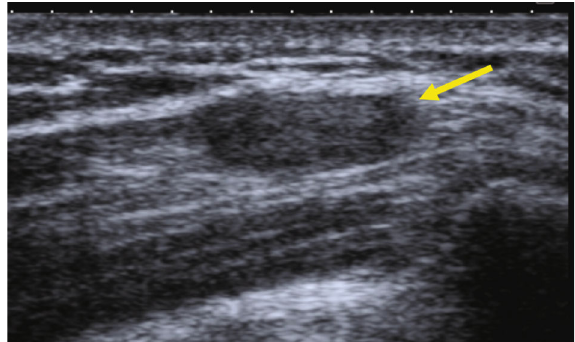
Figure 2: Ultrasonography of the right shoulder identi fi ed a hypoechoic nodular formation (yellow arrow) in the posterior deltoid, with approximately 8 × 10 × 13 mm in